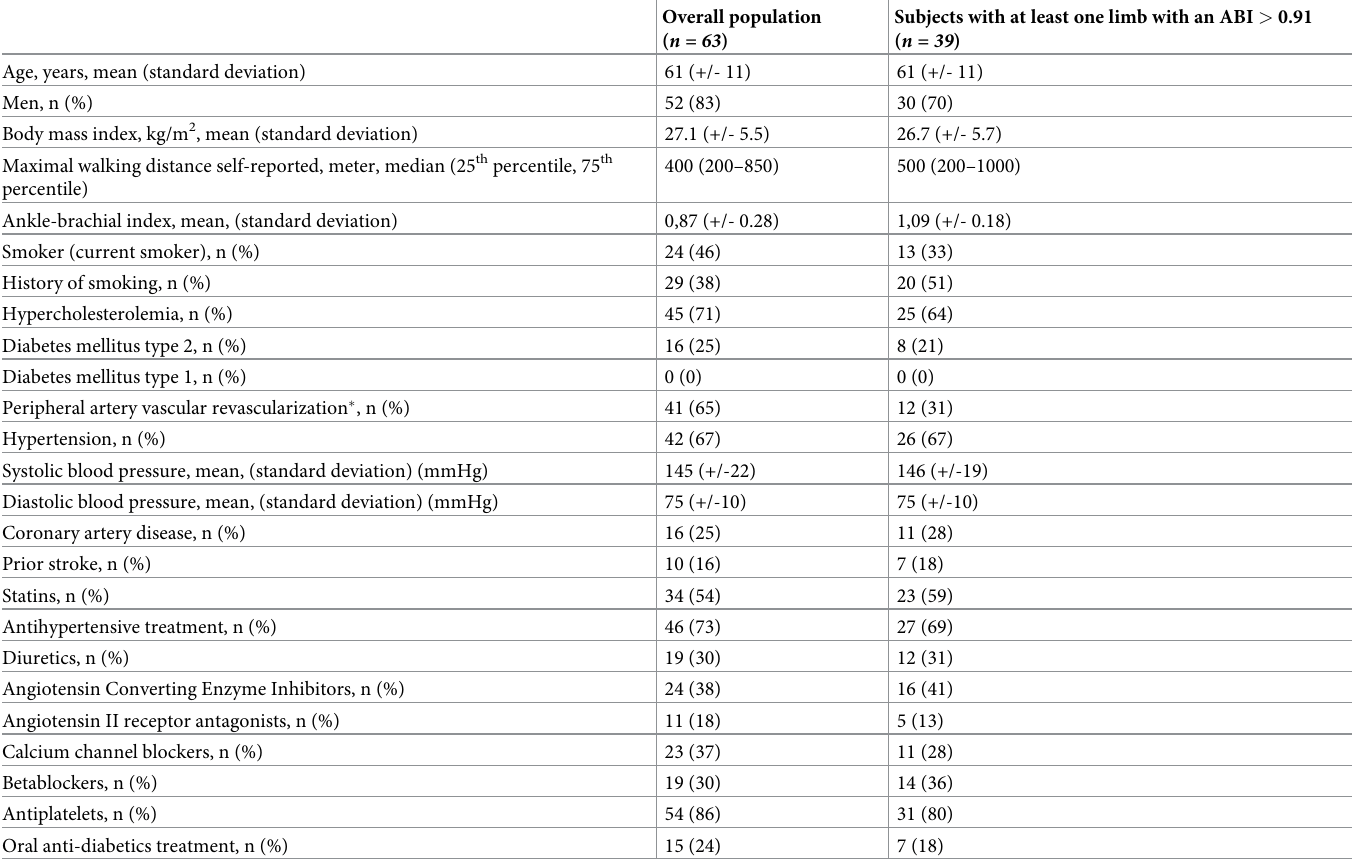
Table 1. Population characteristics.